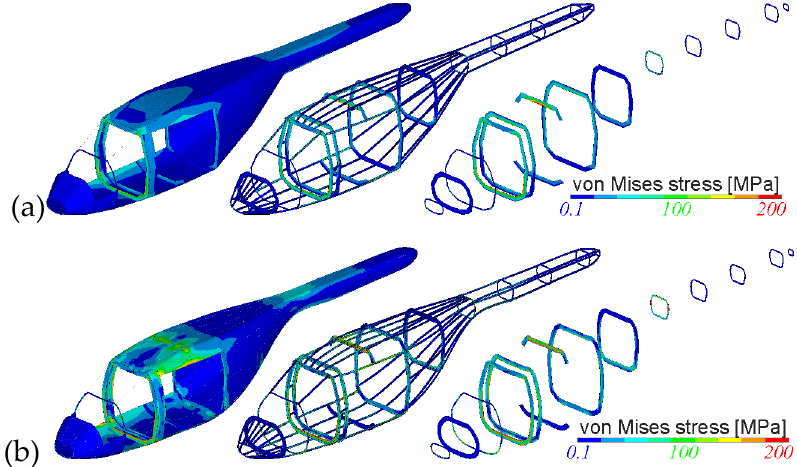
Figure 22. Static hovering analysis: ( a ) coarse discretization; ( b ) fine discretization.